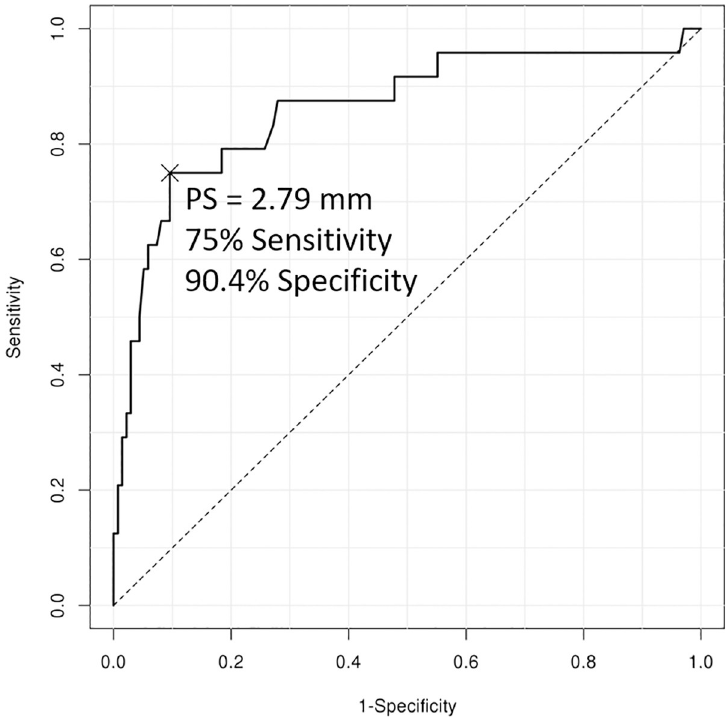
Fig 4. Receiver operating characteristic curve analysis of posterior translation of the radial head for grade 2 lateral collateral ligamentous complex lesion.